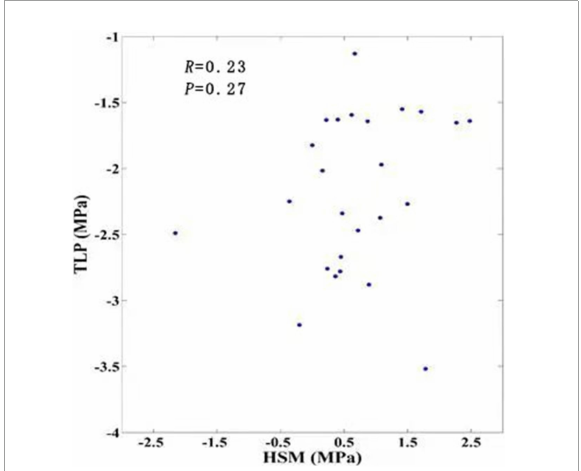
FIGURE2 Relationship between stem HSM and TLP paired according to AI levels ( n = 25). The Pearson correlation coefficient ( R ) and its corresponding p -value are presented in the upper left.